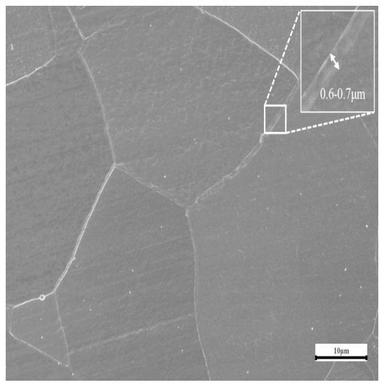
SEM mental and modelling signals. image of grain boundary for ferrite microstructure with average grain size = 57 μm.